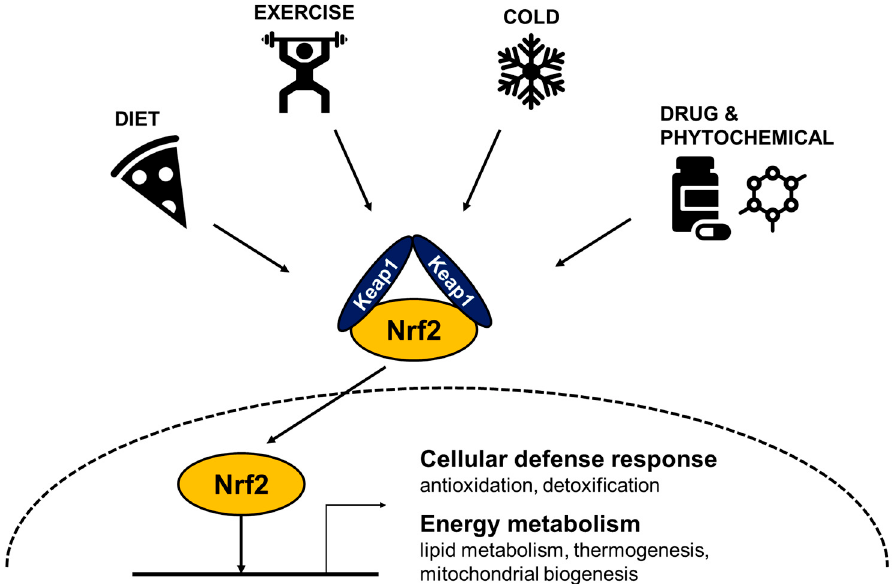
Figure 1. Cellular stresses activate Nrf2 to induce defense systems, reduce body weight, and increase energy expenditure. Schematic diagram of Nrf2-induced responses against various cellular stresses. Cold exposure, physical exercise, food intake, and xenobiotic chemicals activate Nrf2 to transcribe its target genes involved in antioxidation, detoxification, mitochondrial biogenesis, and energy expenditure. ROS can be produced by cold, exercise, high energy diets, and chemical activa- tors that can disrupt Kelch-like ECH-associated protein 1 (Keap1) and Nrf2 interaction to increase Nrf2 abundance and subsequent nuclear translocation of Nrf2. In the nucleus, Nrf2 forms a hetero- dimer with a small Maf protein and binds to antioxidant response element (ARE) in the promoter